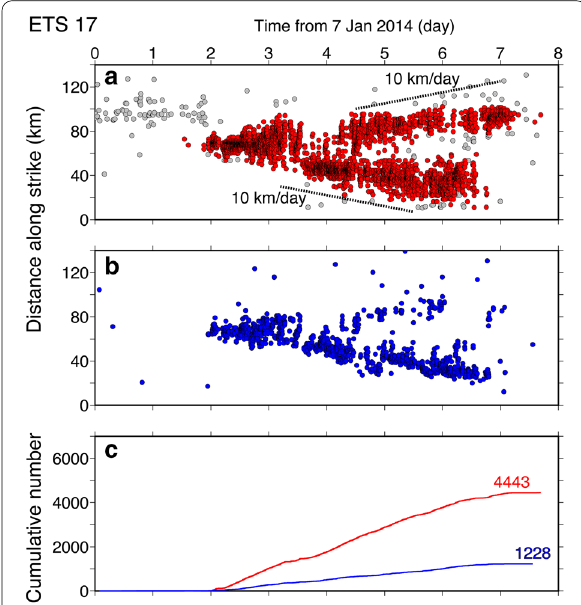
Fig. 3 Space–time plots of tremor hypocenters in event ETS 17 ( a ) from this study and ( b ) from the NIED hybrid catalog. Gray circles in ( a ) are isolated events that were determined to not be part of an ETS event. c Cumulative count of tremor hypocenters (red) from this study and (blue) from the hybrid catalog